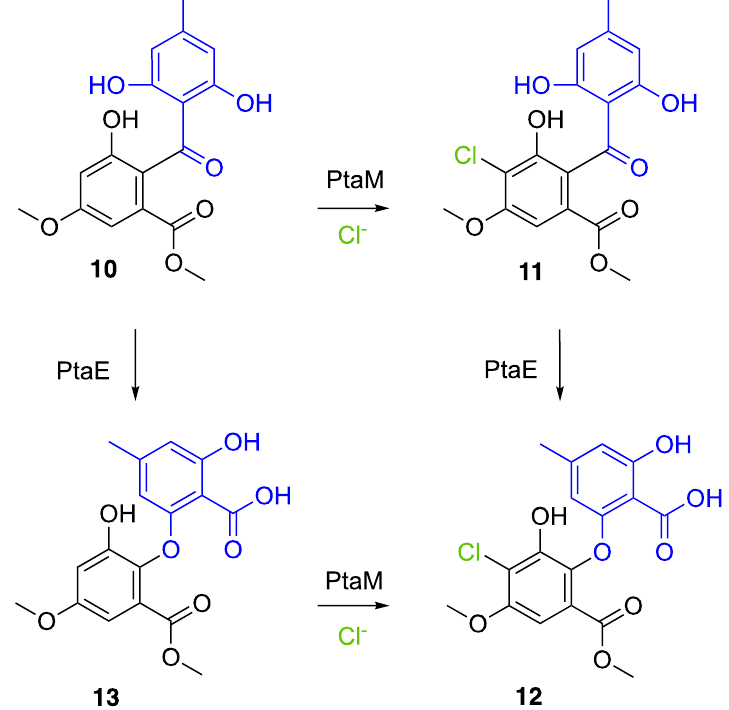
Figure 14. Chlorination of isosulochrin ( 10 ) by PtaM in P. fici to obtain chloroisosulochrin ( 11 ), a precursor of pestheic acid ( 12 ). Isosulochrin ( 10 ) can be oxidized by PtaE to form RES-1214-1 ( 13 ), which is chlorinated by PtaM to form pestheic acid ( 12 ) in Pestalotiopsis sp. Geodin ( 17 ) is a chlorinated metabolite produced by diverse fungal species and in FDH, GedL, for the dihalogenation step of sulochrin ( 14 ) in dihydrogeodin ( 15 ) (Figure 15).